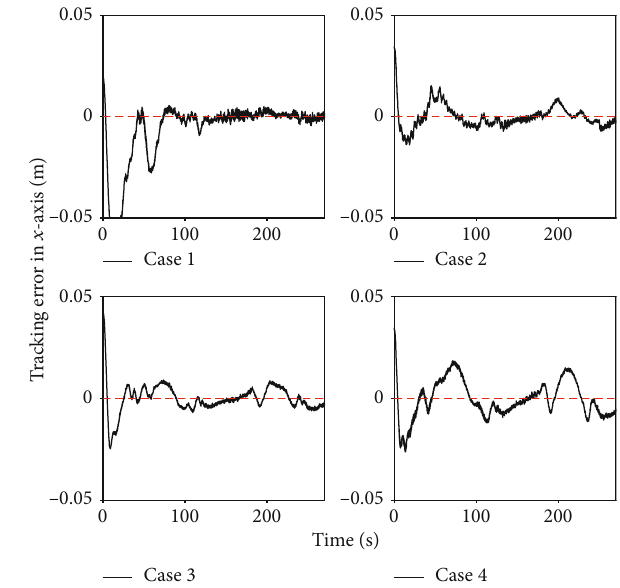
Figure 5: Experimental result: tracking error of simulator in x -axis.